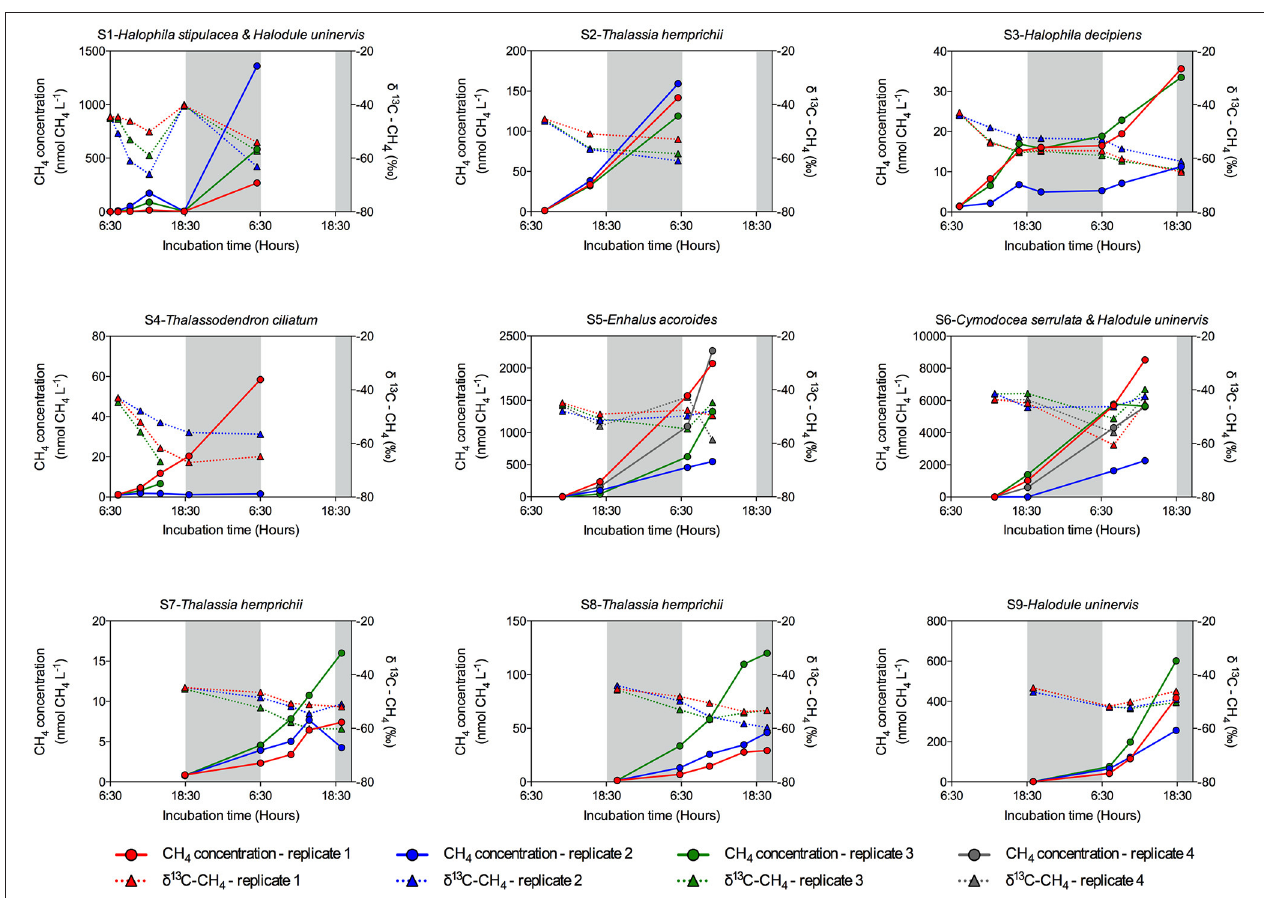
FIGURE 2 | Evolution of CH 4 concentration (circles and solid lines) and its isotopic ( δ 13 C–CH 4 ) signature (triangles and dashed lines) in the sediment and seagrass incubations for each seagrass station. Data from each replicate (in color code) are shown. Gray shaded area corresponds to night time. Note the different scale in Y left